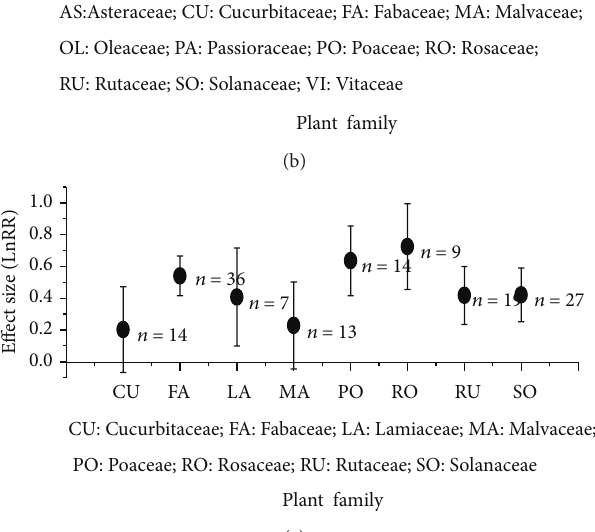
95% CIs: −0.21 with −0.29∼− 0.14; −0.43 with −0.60 ∼ −